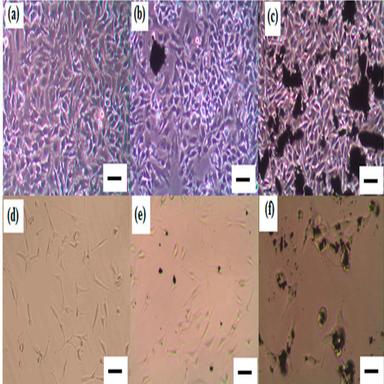
Phase contrast images of confluent HeLa cells with (a) control, (b) 50 μg/mL, and (c) 500 μg/mL of the MXenes. Bright field images of low density of HeLa cells treated with (d) control, (e) 50 μg/mL, and (f) 500 μg/mL of the Ti2CTx MXenes. (scale bar: 50 μm)